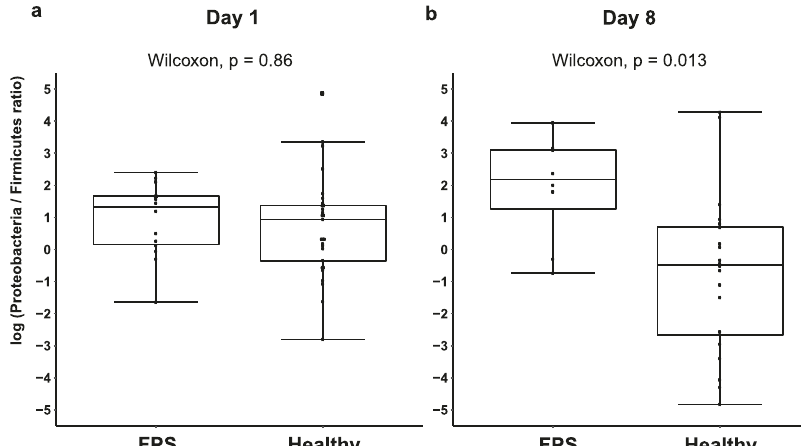
Fig. 5 Rectal Proteobacteria/Firmicutes ratio in healthy puppies and those that later developed FPS. The Proteobacteria/Firmicutes ratio was calculated for both healthy puppies and those that later developed FPS in samples from a 1 and b 8 days post-partum. The Y axis indicates log transformed Proteobacteria/Firmicutes ratios. The rectal Proteobacteria/Firmicutes ratio on Day 8 was higher ( P = 0.013) in puppies that later developed FPS compared to healthy puppies. Each box includes the interquartile range; the line within the box and whiskers represents the median and range, respectively. Each dot represents an individual sample. Sample size: Day 1: FPS-13, healty-27; Day 8: FPS-8,